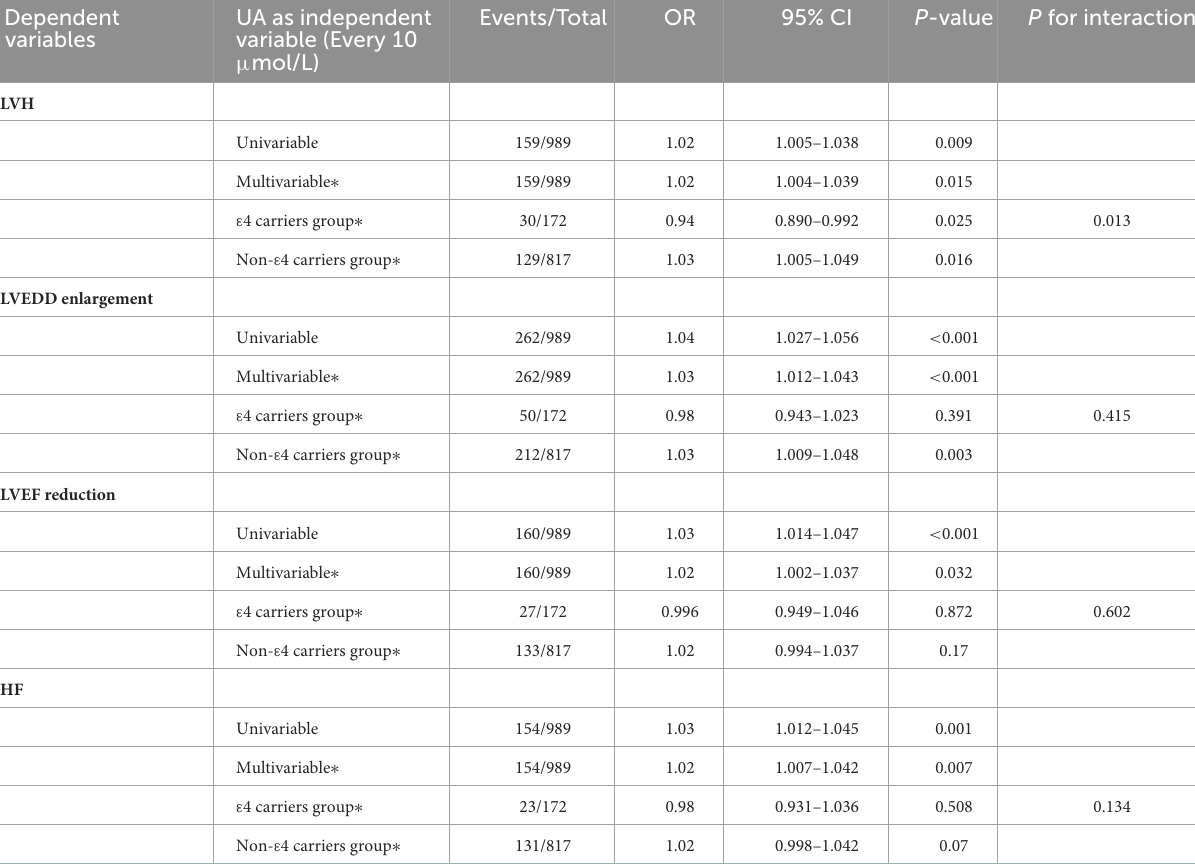
TABLE 3 Univariate and multivariate regression analyses of the effect of serum UA level on left ventricular remodeling and cardiac function. Dependent